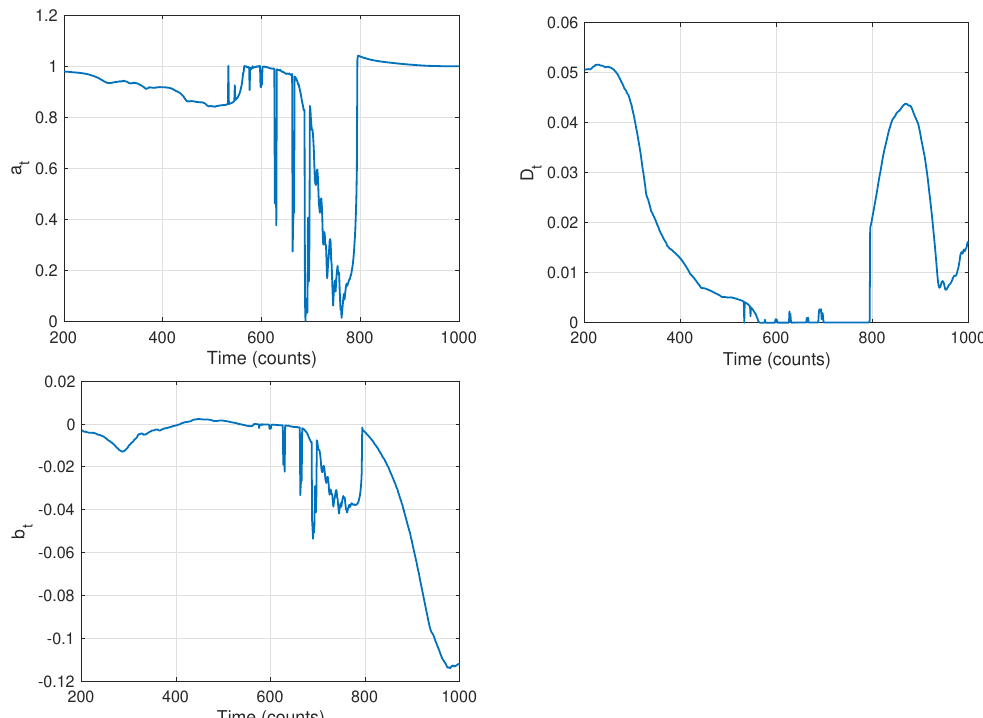
Figure 10. Results of stage 1: time varying estimates of parameters ( left ) a , ( center ) D , and ( right ) b , using a sliding window of size h = 200.